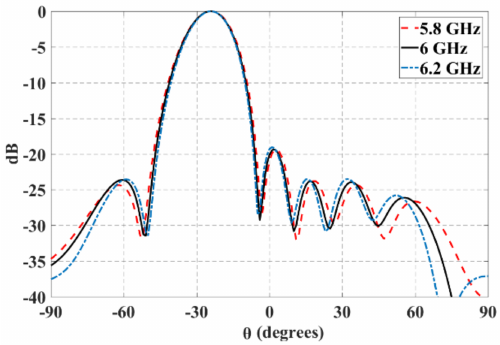
Figure 15. Normalized radiation pattern at 5.8 GHz, 6 GHz, and 6.2 GHz and for θ 0 = − 25 ◦ .